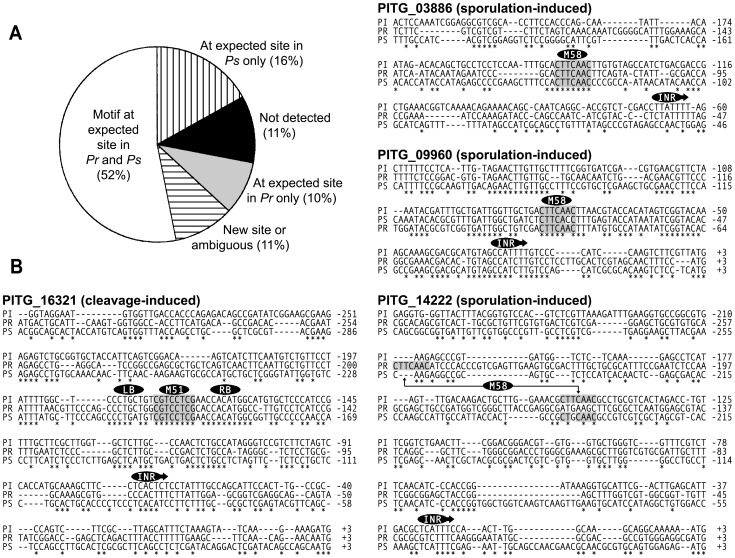
Interspecific conservation of motifs.
(A) Pie chart illustrating the fraction of the 103 motifs that were detected at the same (i.e. expected) location in alignments of orthologous promoters from P. infestans (Pi), P. ramorum (Pr) and P. sojae (Ps), in the same location in P. ramorum or P. sojae compared to P. infestans, in a new location in P. ramorum or P. sojae, or not detected outside of P. infestans. (B) Representative CLUSTAL alignments. Shown on the left side of the figure are alignments of PITG_16321 (containing M51) with its orthologs from P. ramorum and P. sojae. Conserved blocks to the left and right of M51 are labeled as LB and RB, respectively. Shown in the right column are alignments of PITG_03886, PITG_09960, and PITG_14222, which contain M58. Also marked is the Initiator core promoter element, INR, which normally spans the transcriptional start site.